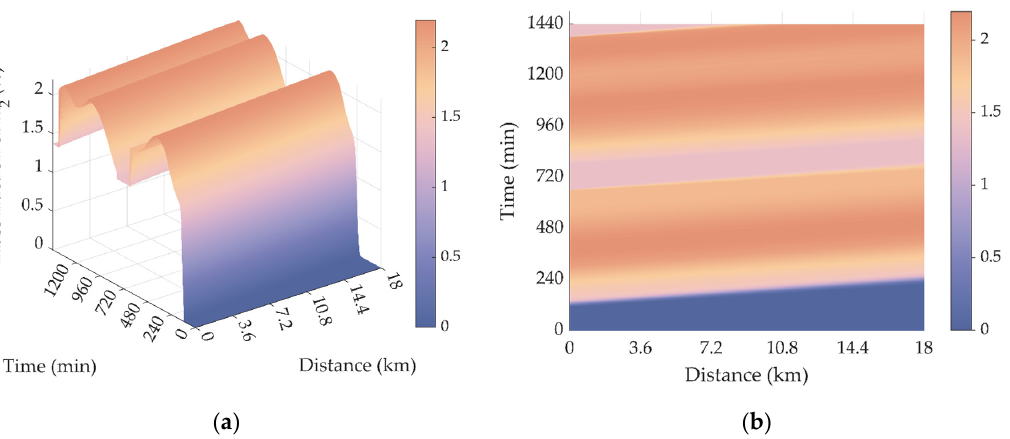
Figure 18. The distribution of hydrogen mass fraction in Pipe 4 in Scenario III: ( a ) Three-dimensional diagram; ( b ) top view.